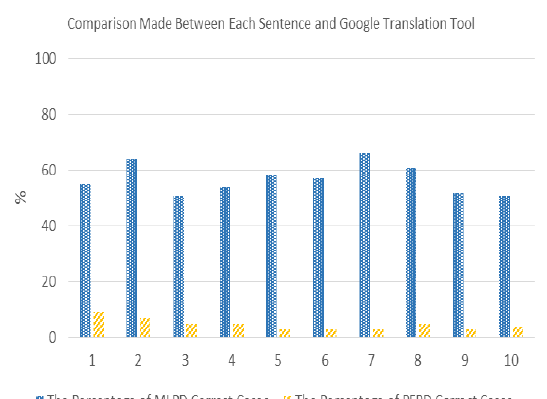
Figure 9. Percentage of results of comparison made between each sentence and original source.